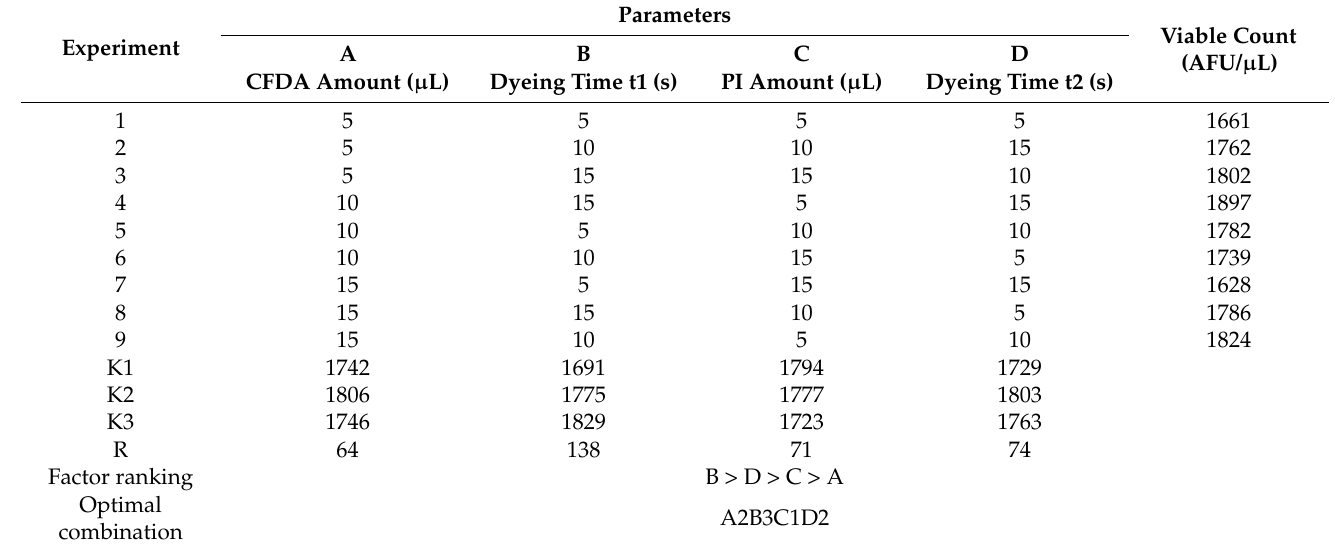
Table 3. Orthogonal test for identifying the optimal combination of dye concentration and dye- ing time.